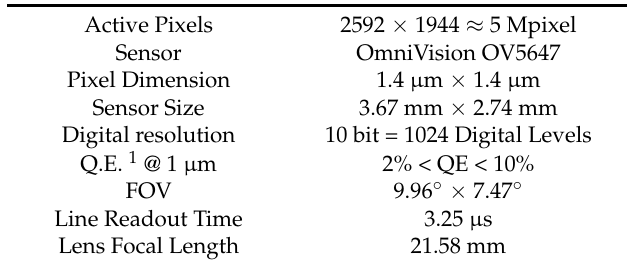
Table 1. Properties of the Raspberry Pi camera and custom